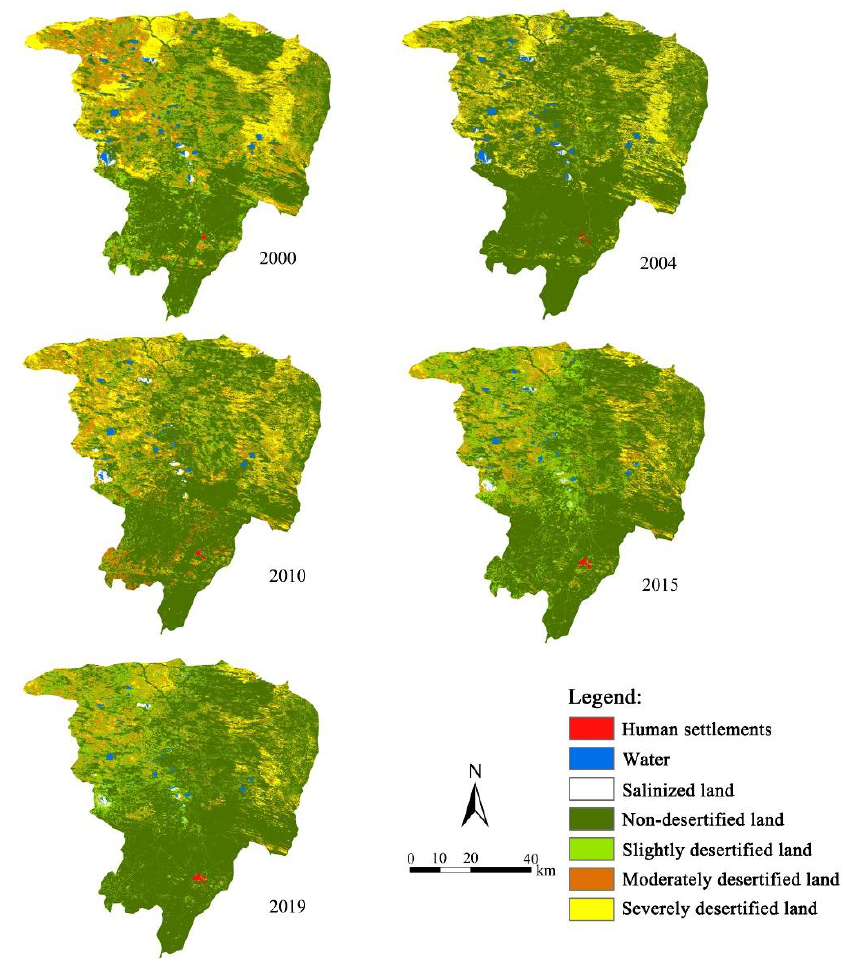
Figure 10. Classification map in the Zhenglan Banner.